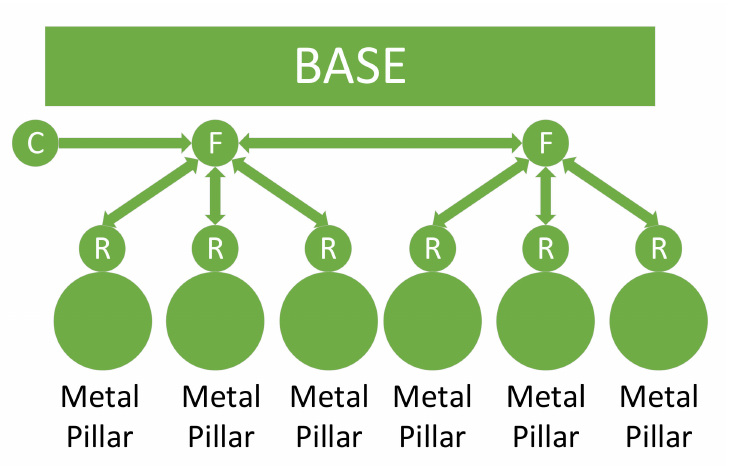
Figure 15. Schematic.